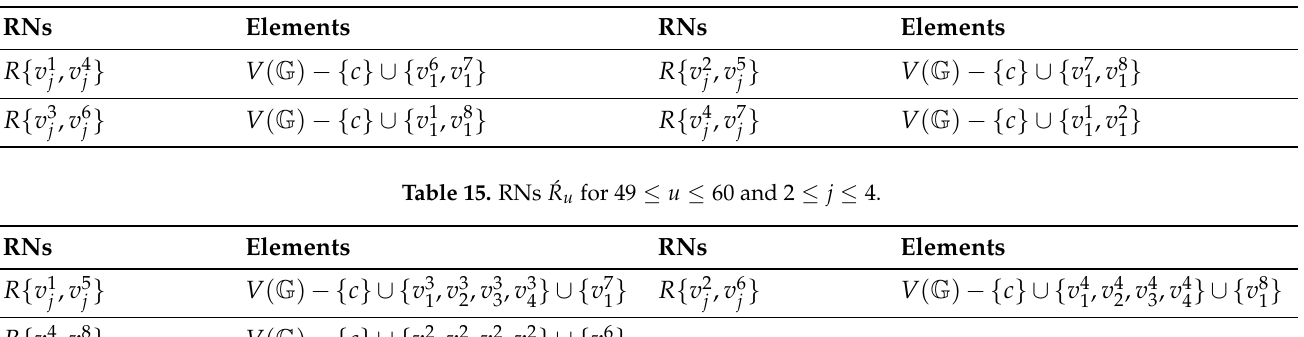
Table 14. RNs ´ R u for 37 ≤ u ≤ 48 and 2 ≤ j ≤ 4.